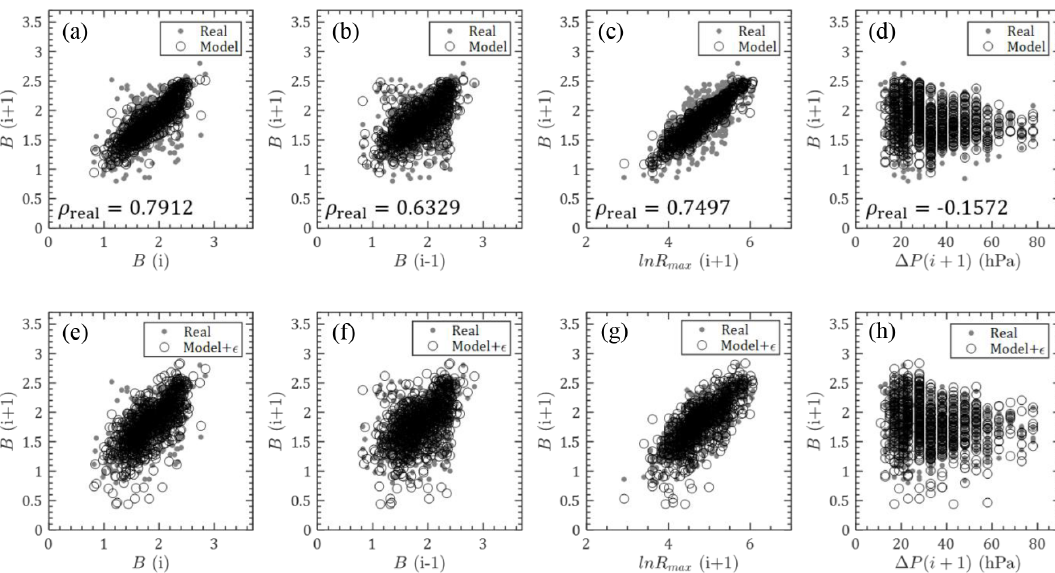
Figure 11. Comparison of B s between model and real observations: (a–d) relations between B s (i) , B s (i − 1 ) , ln R max , s (i + 1 ) , (cid:49)P(i + 1 ) and B s (i + 1 ) without errors; (e–h) relations between B s (i) , B s (i − 1 ) , ln R max , s (i + 1 ) , (cid:49)P(i + 1 ) and B s (i + 1 ) with errors ( ρ real is the correlation coefficient for real observation